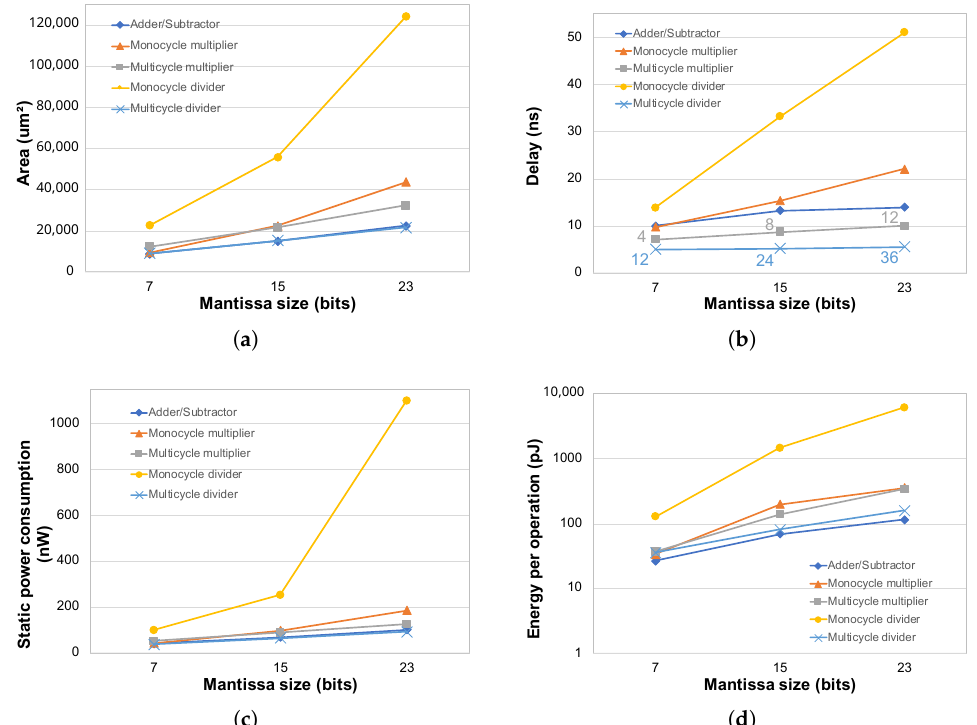
Figure 9. Floating point unit characterization in terms of mantissa size. ( a ) Area. ( b ) Delay. ( c ) Static power. ( d ) Energy per